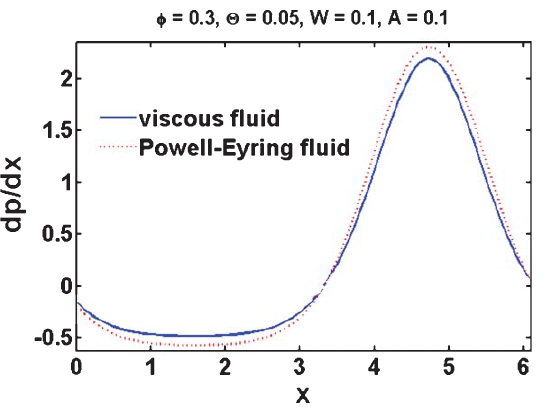
Fig. 9. Comparison of viscous and Powell-Erying fluids for dp/dx .